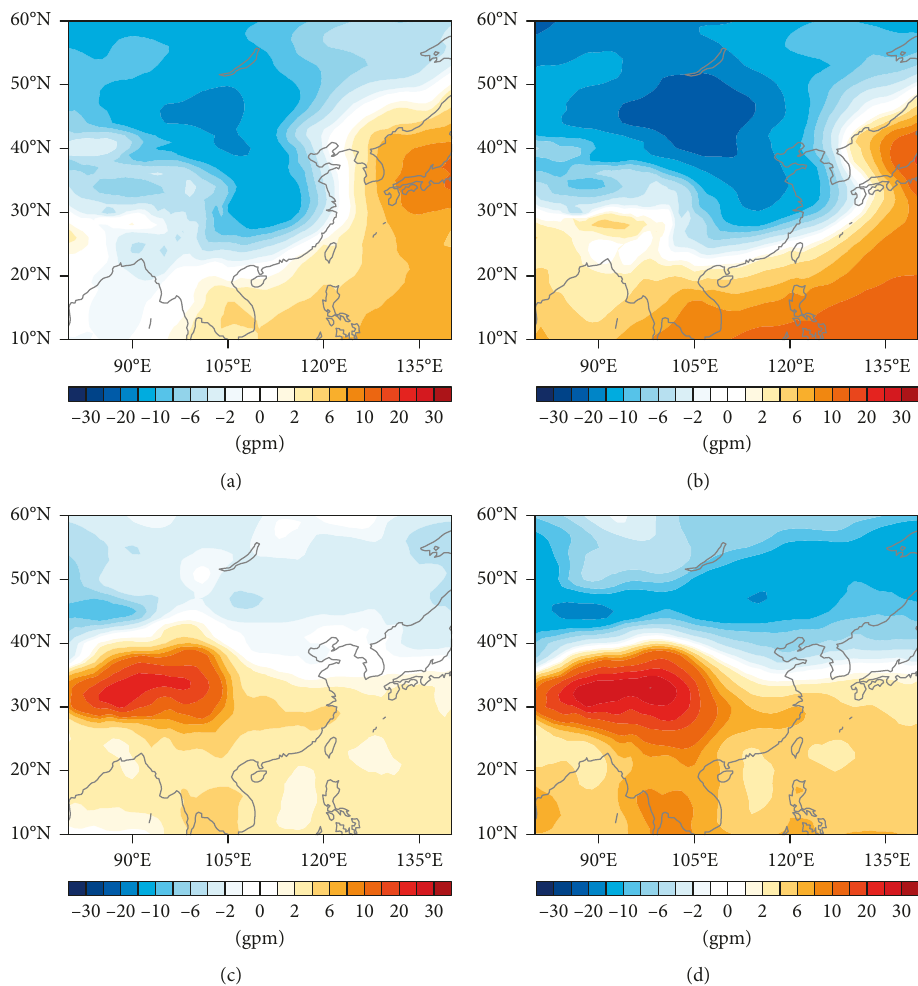
Figure 1: Systematic error of geopotential height on 500hPa in January and July (unit: gpm): (a) 24h forecast in January; (b) 48h forecast in January; (c) 24 h forecast in July; (d) 48h forecast in